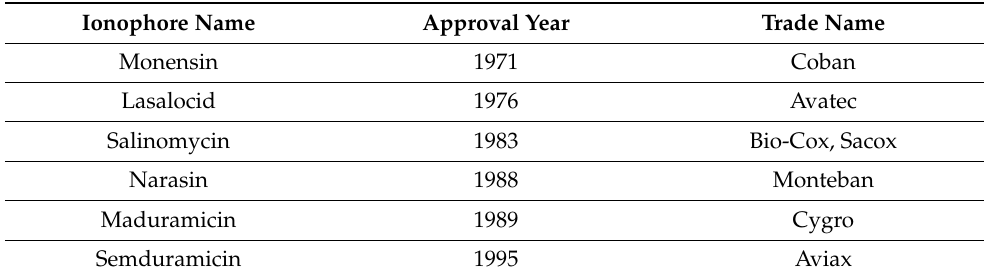
Table 1. Ionophores approved as anticoccidials.